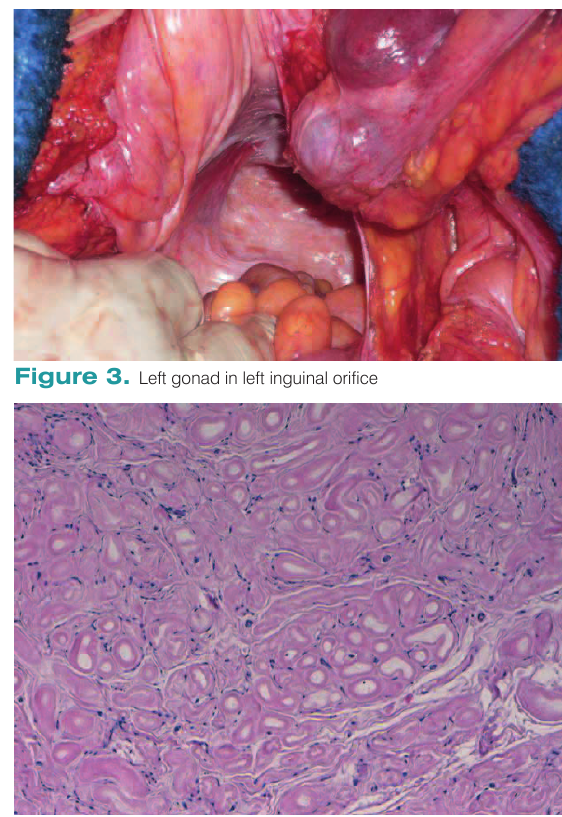
Figure 4. Haematoxylin and eosin (H & E) staining, at 10x magnifi cation. Atrophic left testicle. Fibrous and hyalinized seminiferous ducts without spermatogenesis